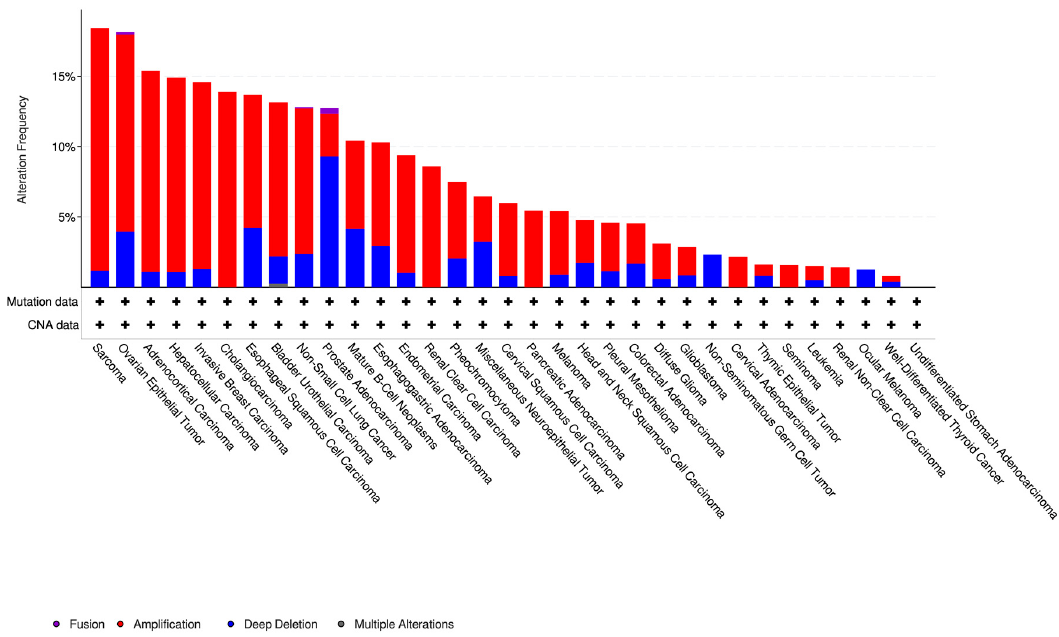
Figure 3. Alteration of olaparib-modulated lncRNAs across cancer types. Overall alteration frequency of olaparib-modulated lncRNAs across different cancer types in the PanCancer Atlas cohort, obtained from cBioPortal.